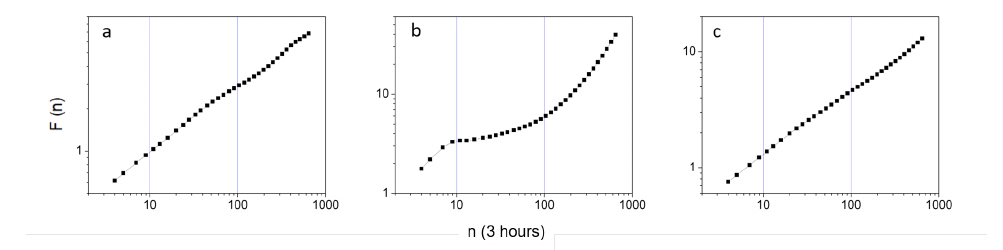
Figure 6. Coxim (MS) is the city that presented the greatest range variation in the α for solar radiation, moving from an anti-persistent state in ( a ) El Niño to a sub-diffusive one during ( b ) La Niña, and become persistent in ( c ) the neutral year, for a time scale window greater than ten